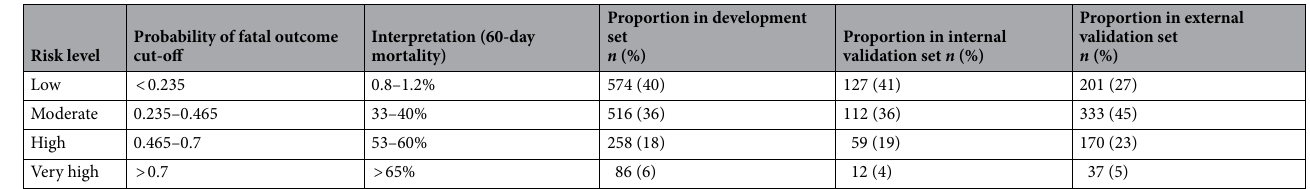
Table 3. Risk stratification of